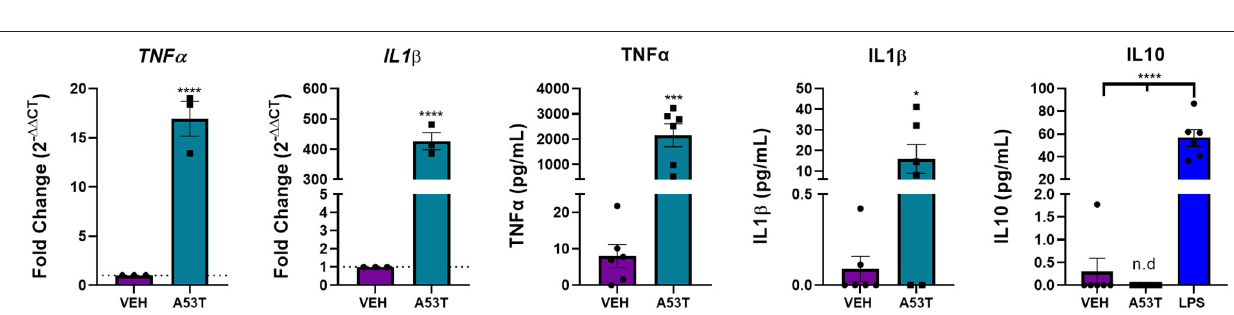
FIGURE 5 | The expression and release of proinflammatory cytokines are upregulated in A53T-exposed microglia. Microglia were exposed to 1 µ g/mL misfolded A53T or vehicle (VEH) for 24h. A53T-exposed microglia display increased gene expression of the classical proinflammatory cytokines, TNF α and IL1 β compared to VEH treated cells ( n = 3 wells/treatment). TNF α and ILI β release was also increased following A53T exposure (ELISA; n = 6 wells/treatment). IL10, an anti-inflammatory cytokine, was not released in response to A53T, but was detected following treatment with 100ng/mL LPS ( n = 6 wells/treatment); one-way ANOVA with Dunnett’s post-hoc . Other ELISAs are reported as mean ± SEM, using an unpaired Student’s t -test; **** P ≤ 0.0001, *** P ≤ 0.001, and * P ≤